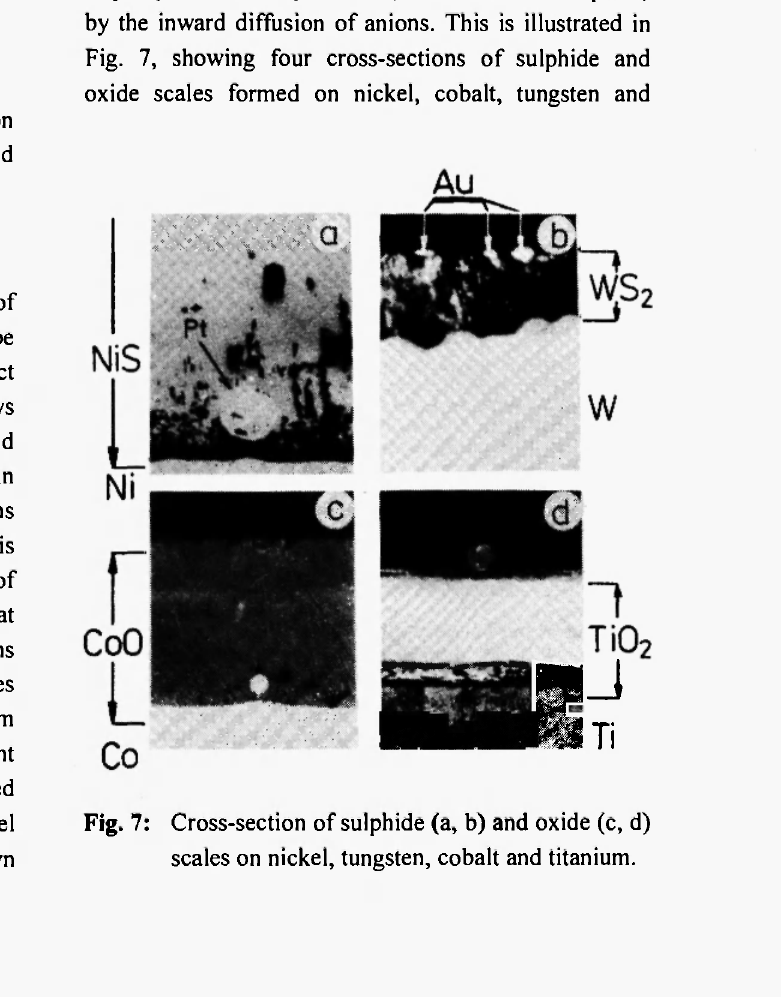
Fig. 6: Temperature dependence of chemical diffusion coefficients for some metal sulphides and oxides, in Arrhenius plot.